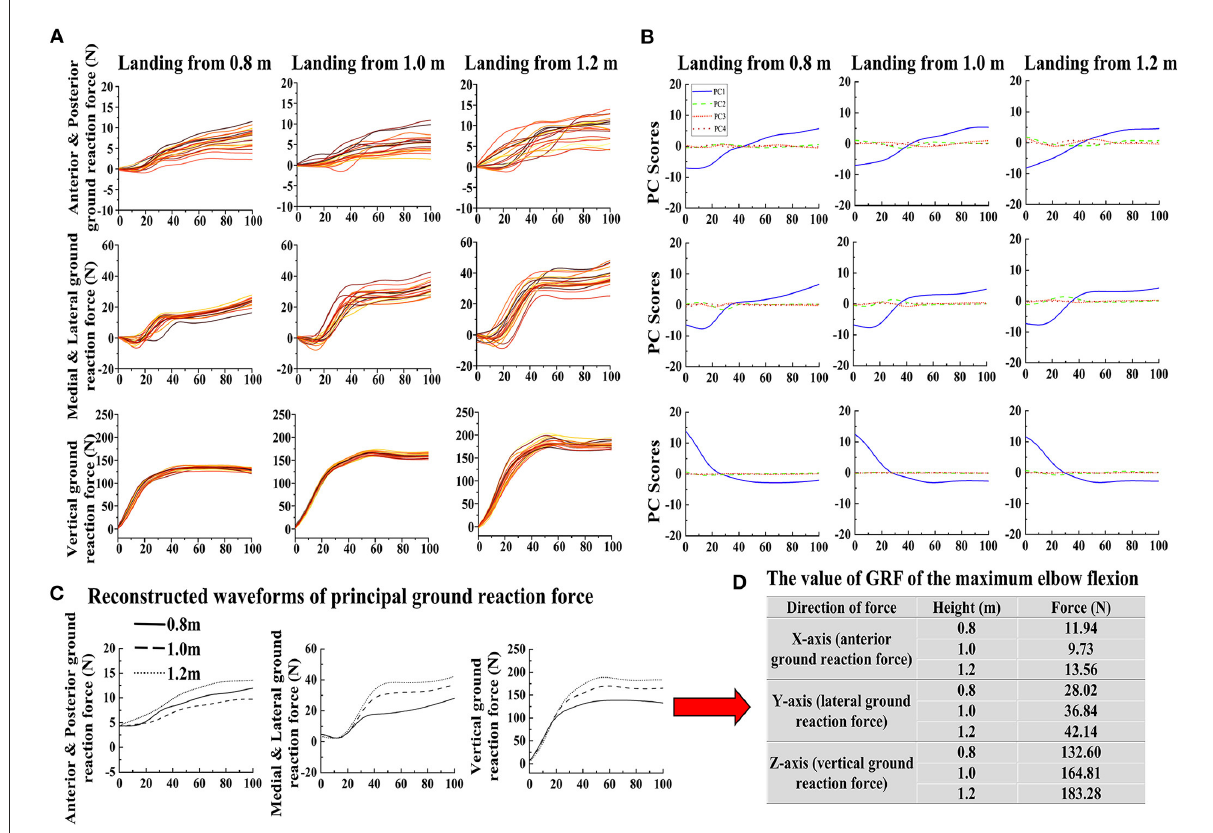
FIGURE3 (A) The raw data waveform of GRF for each direction (X-axis: anterior and posterior GRF; Y-axis: lateral and medial GRF; Z-axis: vertical GRF) in each height (0.8, 1.0, and 1.2m). (B) The first four PC scores PC i of each landing height and each direction GRF. (C) The reconstructed waveforms of each landing height and each direction GRF. (D) The extracted principal GRF value of the maximum elbow flexion data point based on the reconstructed waveform in each direction during landing from different